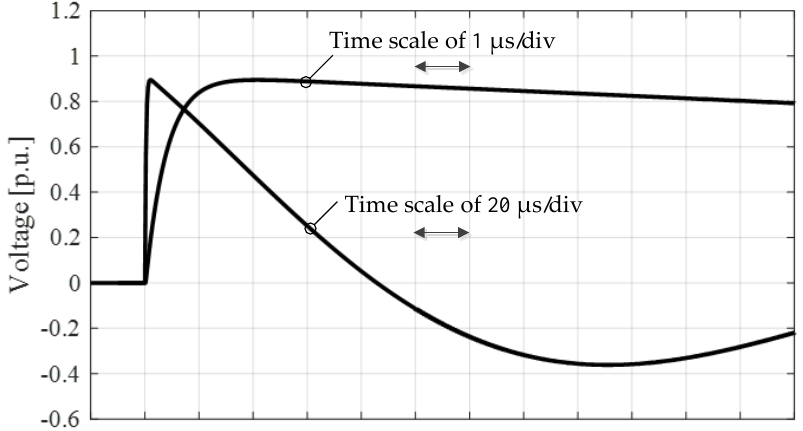
Figure 12. Generated waveform of Case 9 in Table 4 and by the proposed approach.